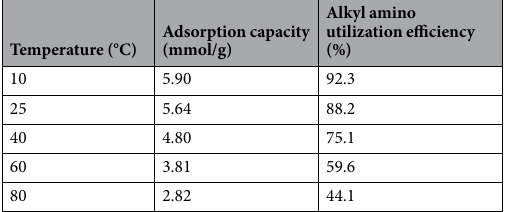
Table 2. Adsorption capacities and alkyl amino utilization efficiency of PP-AM-HBP-NH 2 fibers (alkyl amino content was 6.39 mmol/g) at different adsorption